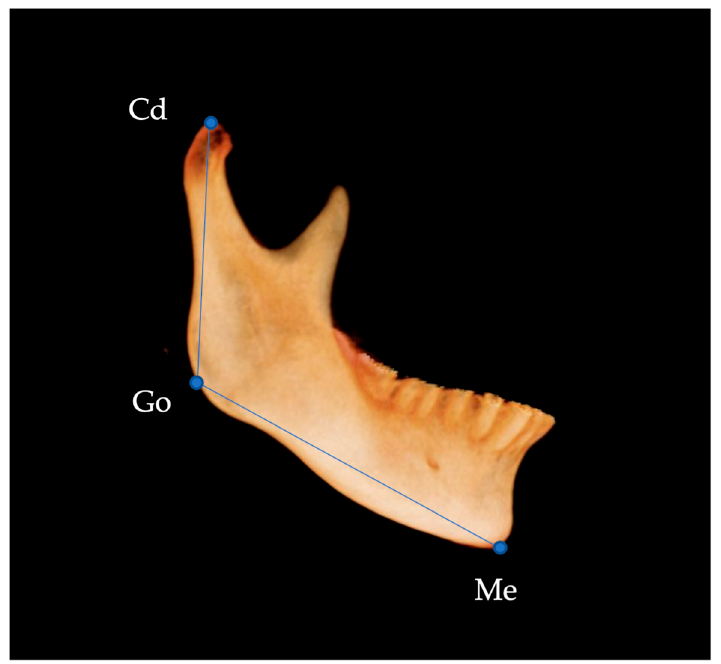
Figure 3. Length of mandibular body and ramus. Cd, uppermost point of the condyle; Go, gonion; Me, menton.